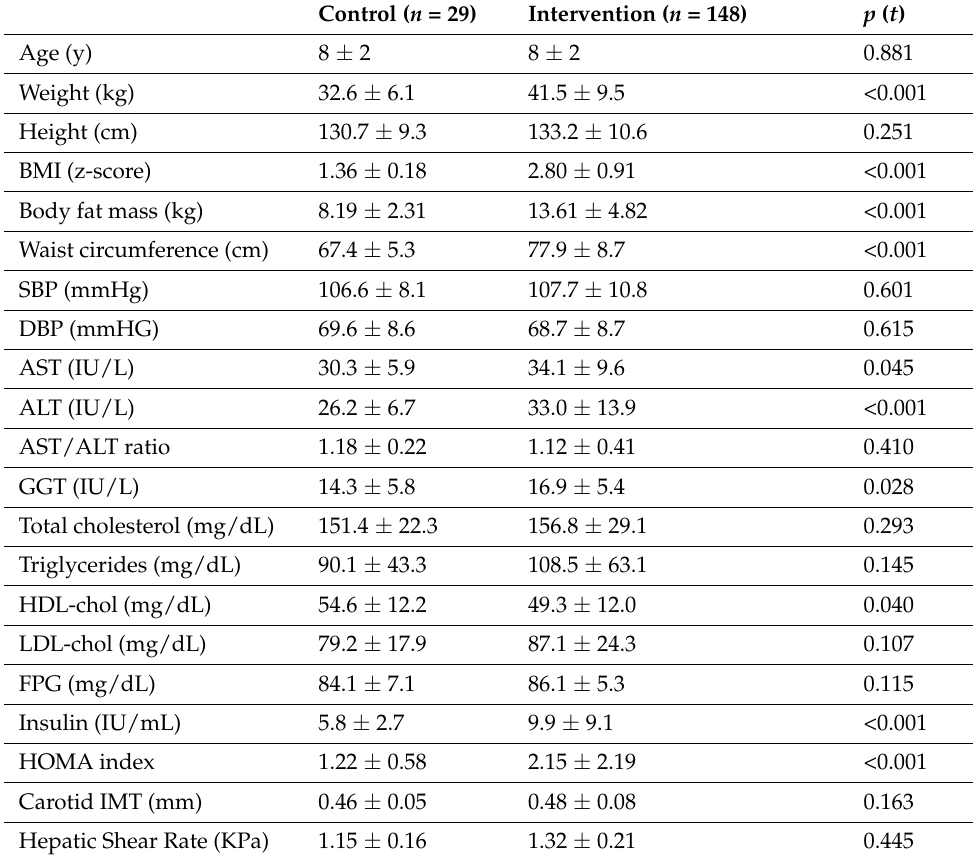
Table 1. Baseline anthropometrical and clinical characteristics of the